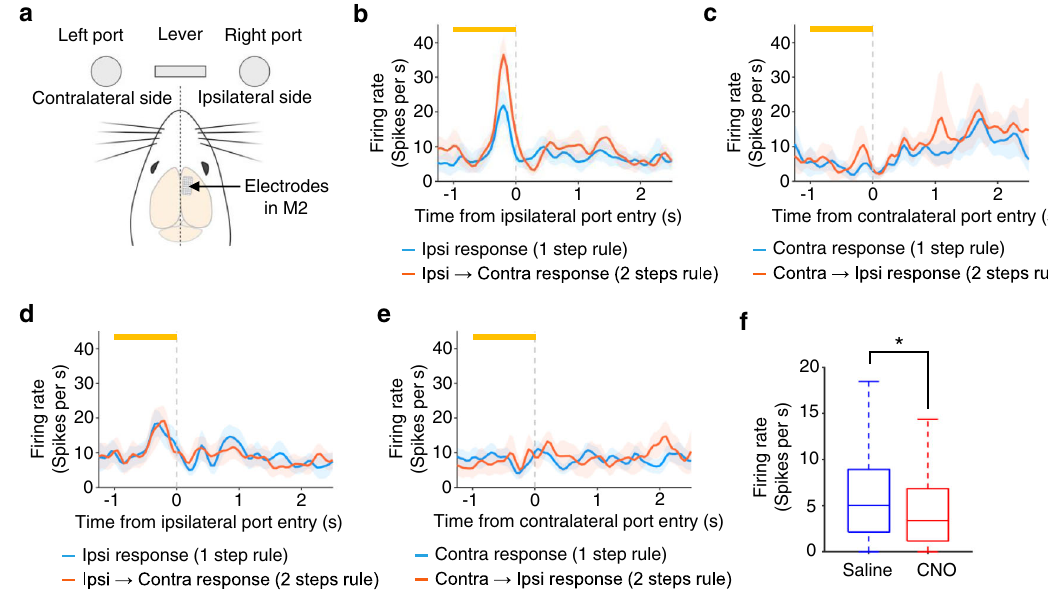
Fig. 5 | Chemogenetic silencing of ACC decreased fi ring rate during pre-choice period in M2 neurons. a Ipsilateral and contralateral sides viewed from a rat ’ s cerebral hemisphere in which M2 single-unit activity was measured. Rats were implanted with Utah array electrodes in M2 of either left or right hemisphere and neural activity was measured during their task performance with IP injec- tionsofsalineorCNOsolutions(20mg/kg).Inthefollowinganalysis,trialswere classi fi ed according to which side port (ipsilateral or contralateral) rats chose as their 1st choices. b Peri-event time histogram (PETH) of a representative single-unit showing rule selective responses before making a correct response to the side port that was located on the ipsilateral side of neural activity mea- surements (ipsilateral condition). In 1 step condition (blue line), the rat made a choice of the ipsilateral port while, in 2 steps condition (red line), the rat made its 1st choice of the ipsilateral port and then made its 2nd choice of the con- tralateral port. Only trials in Rule Switch-blocks were used for constructing the